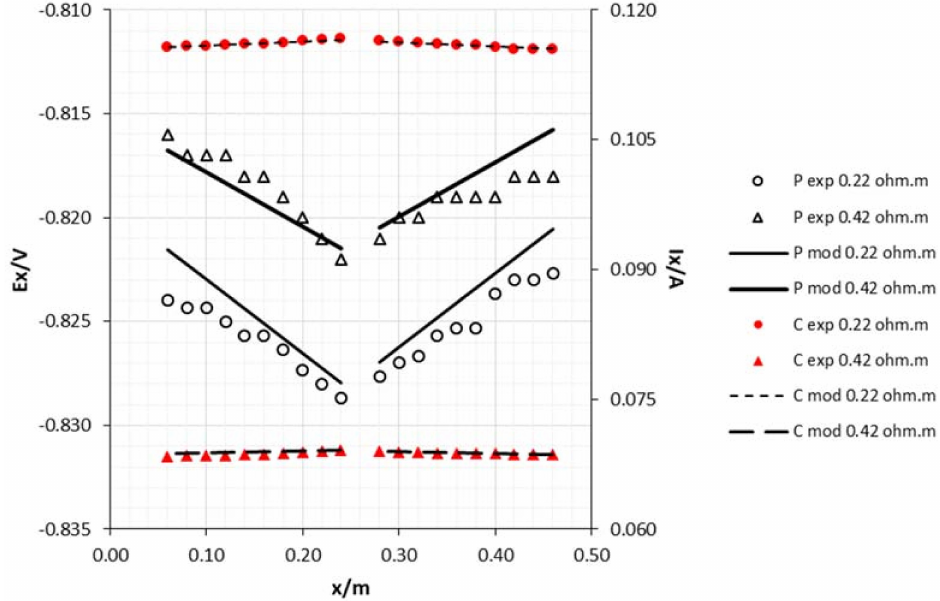
Figure 10. Experimental and model attenuation curves as a function of medium resistivity (sacrificial anode area: 0.0018 m 2 ; cathode diameter: 15 mm and middle draining point). Legend: P—potential; C—current; exp—experimental;